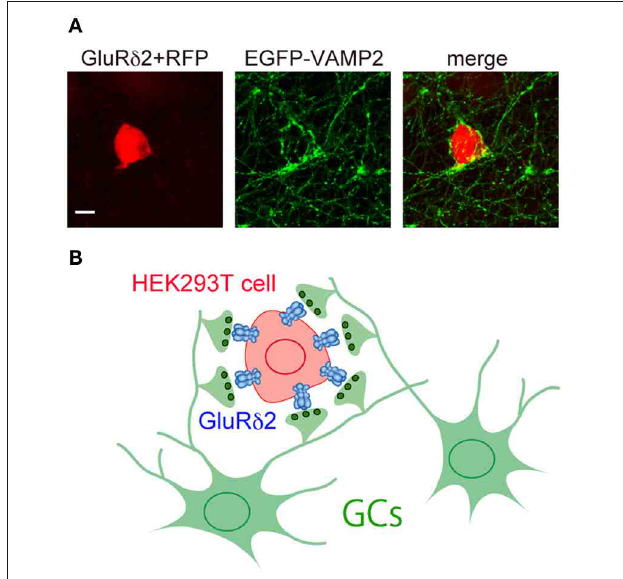
FIGURE 3 | Induction of presynaptic differentiation by GluR δ 2. (A) HEK293T cells transfected with expression vectors for GluR δ 2 and tagRFP (red) were seeded on top of cultured cerebellar neurons transfected with an expression vector for vesicle-associated membrane protein-2 (VAMP-2) fused with EGFP at its N terminus (EGFP-VAMP2) (green). After 2 days of co-culture, cells were immunostained for EGFP. Note that numerous EGFP-VAMP2 signals accumulated on the surface of HEK293T cells expressing GluR δ 2. Scale bar represents 10 μ m. (B) Schematic presentation of the accumulation of GC axon terminals on the surface of HEK293T cells expressing GluR δ